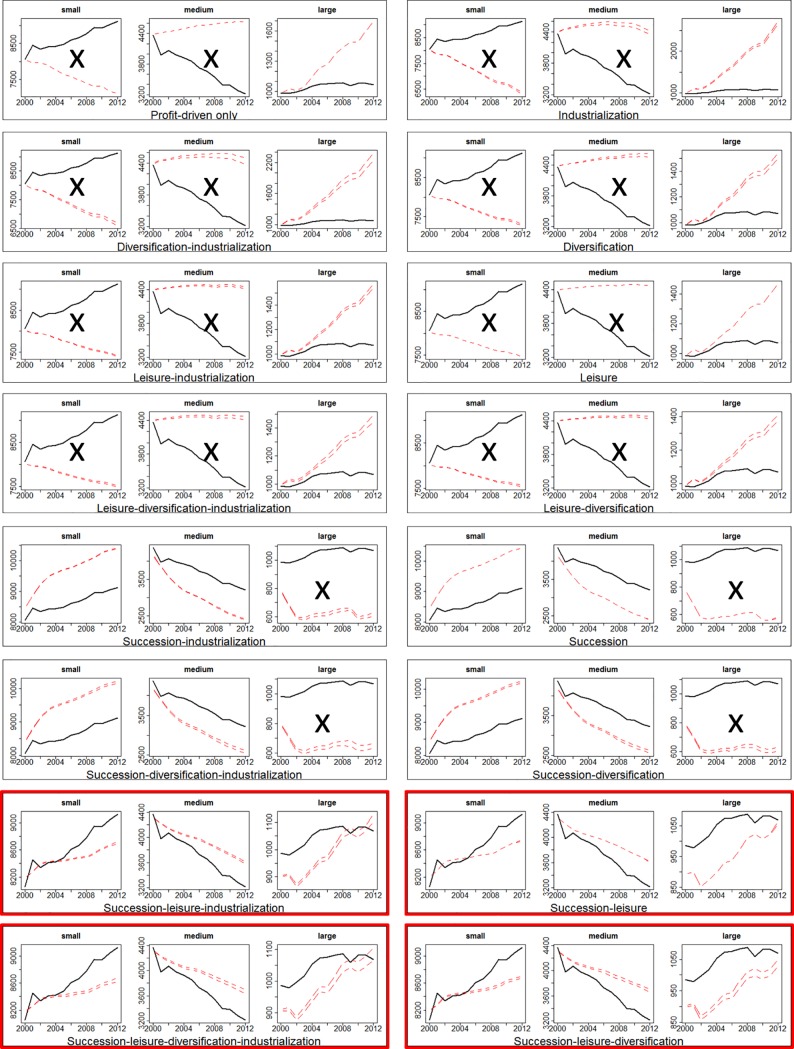
Model selection using pattern-oriented modelling (POM).Each of the sixteen frames shows the results for changes in numbers of small, medium-sized and large farms, after running the model with the labelled drivers switched on (“profit-driven only” means none are switched on). The graphs show the results from the model with red dashed lines (capturing minimum and maximum values from model runs) and the empirical data (from Fig 4) with a black solid line. The selected combinations are highlighted in red rectangles, and reproduce the observed pattern of increasing numbers of small and large farms as the number of medium-sized farms decreases. A black cross is placed where the simulated patterns does not match the empirical ones.